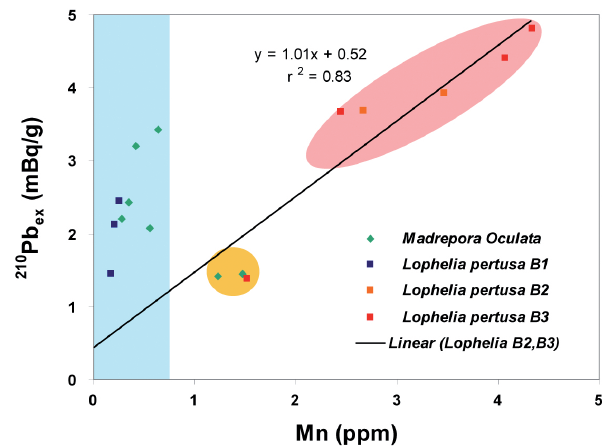
Fig. 4. 210 Pb activities (black dots), 226 Ra activities (grey dots) and Mn content (grey curve) from mechanically and chemically cleaned polyps of Madrepora oculata (a) and Lophelia pertusa (b) speci- mens. Dotted line displays the mean activity of 226 Ra. Horizontal dotted lines represent the limit of the three sampled branches of Lophelia pertusa (B1, B2, and B3).